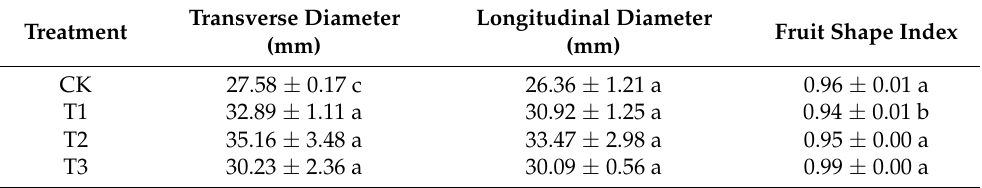
Table 3. Effect of different abaxial leafy supplemental lighting treatments on fruit shape of cherry tomato. Transverse Diameter Longitudinal Diameter Fruit Shape Index Treatment (mm) (mm) CK 27.58 ± 0.17 c